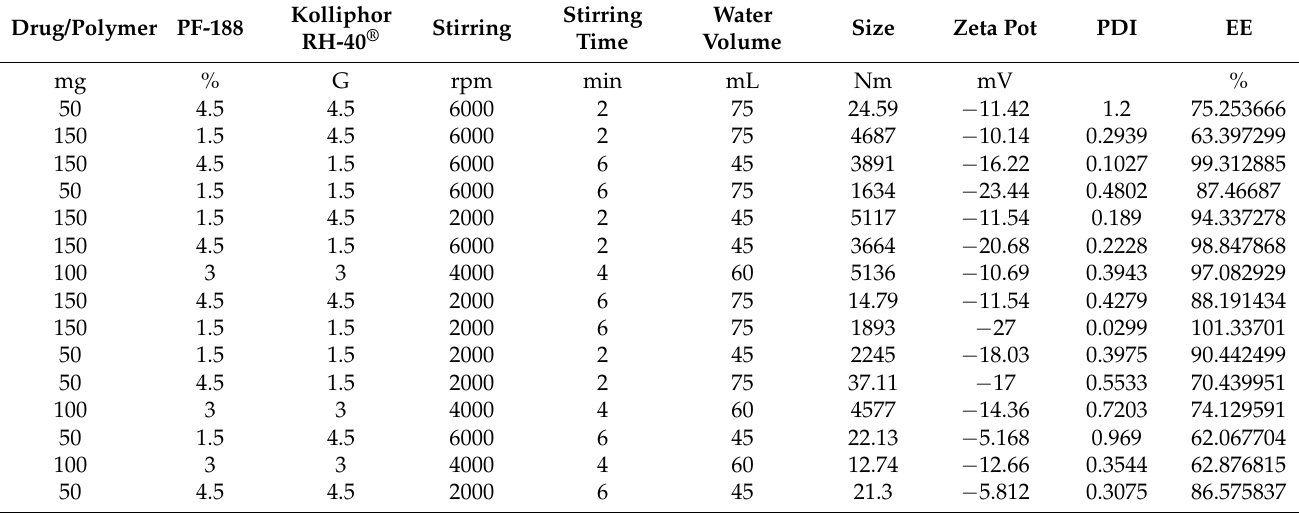
Table 6. Factors and responses in the screening phase.